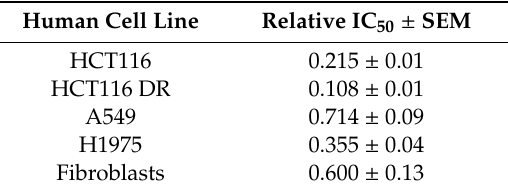
Table 1. Relative IC 50 ( µ M) of ZnD in HCT116, HCT116 DR, A549, and H1975 human cell lines at 48 h. Values shown are relative to the mean of three independent assays and the errors are correspondent to